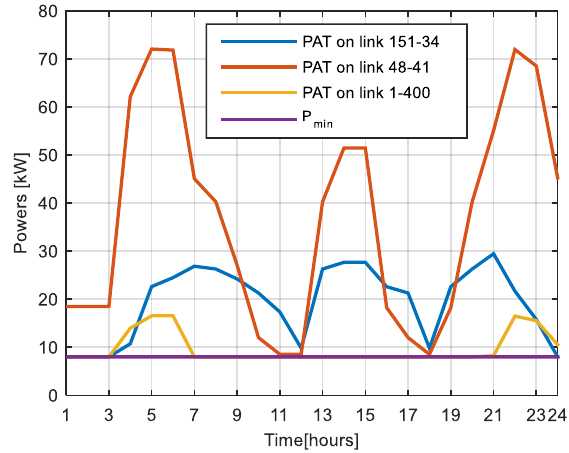
Figure 12. Profiles of hourly powers for three PATs.